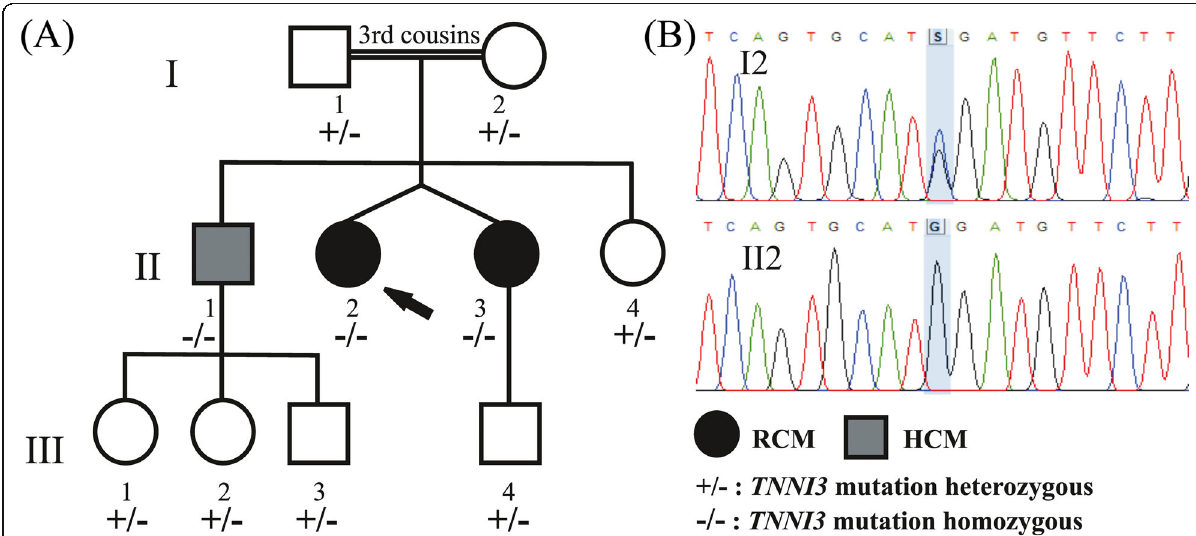
Fig. 1 a The family pedigree is depicted. The proband (shown by arrow, II2) and her dizygotic twin sister (II3) were homozygous for the NM_000363.4:c.586G > C variant and displayed the phenotype of restrictive cardiomyopathy (RCM). Their brother (II1) also homozygous for the same variant displayed the phenotype of hypertrophic cardiomyopathy (HCM). Their children, with age range from 5 to 21 years old (III1: 5, III2: 13, III3 and III4: 21), remain unaffected along with the proband ’ s parents who were found heterozygous for the same mutation. Circle = female. Square = male. Filled symbols = affected individuals. b Electropherogram of the involved sequence fragment of the TNNI3 for the members of the family. The detected mutation is